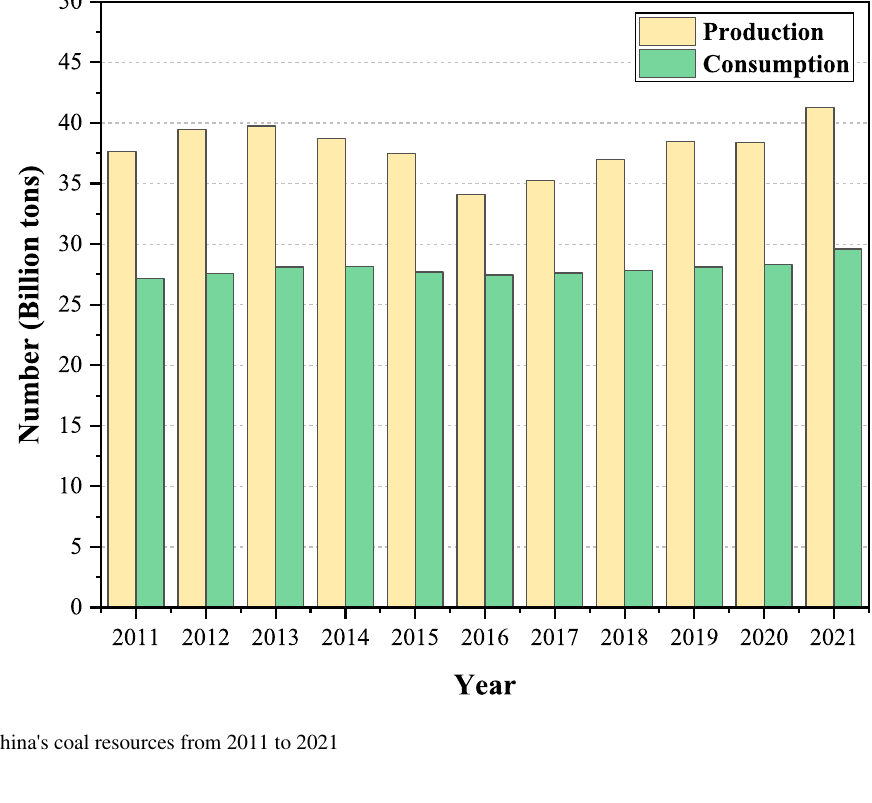
Fig. 2 Changes in China's coal resources from 2011 to 2021